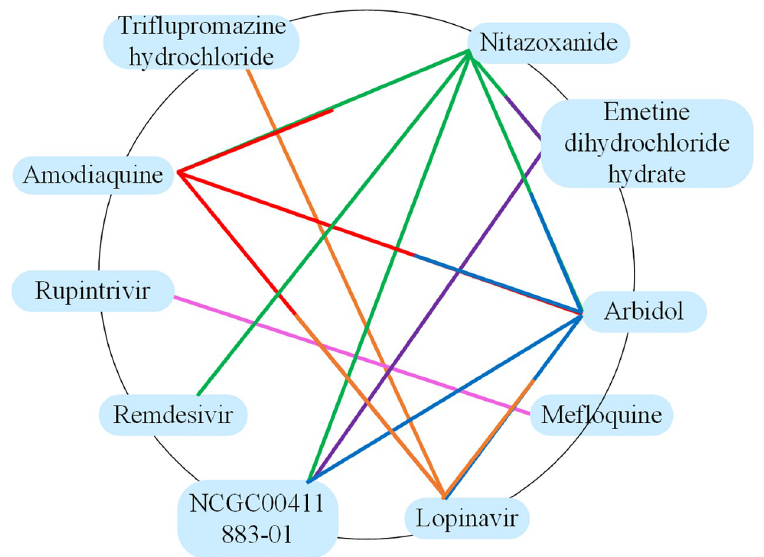
Fig 11. Drug combination to treat